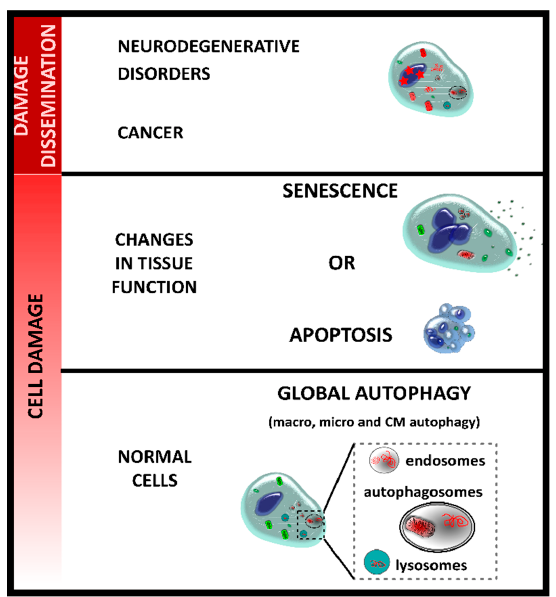
Figure 1. Different stages of cell damage. Autophagy is one of the mechanisms acting as the first barrier against cell damage to avoid the accumulation of non-functional organelles or proteins in the cells. When this mechanism is overburdened, apoptosis or senescence is activated. These mechanisms stop the damaged cells’ dissemination and prevent the apparition of age-related diseases, such as neurodegenerative disorders or cancer. An accumulation of damaged organelles and proteins and changes in the genetic material are observed in these diseases.